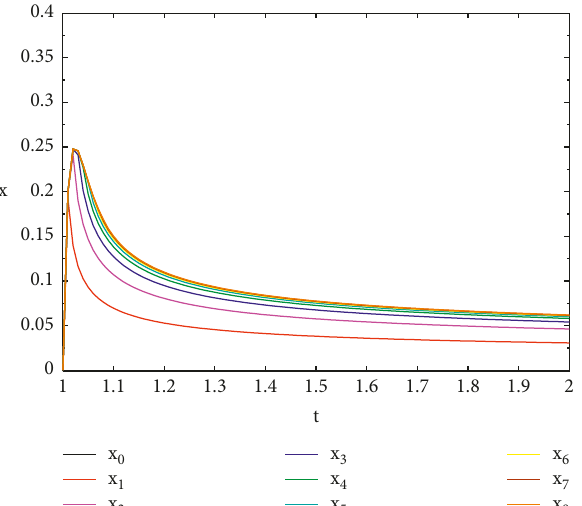
Figure 1: Case β � 0 and ρ ⟶ 1: the monotone iterative sequence of equation (31) under the Riemann–Liouville fractional derivative for α � 0 . 5.